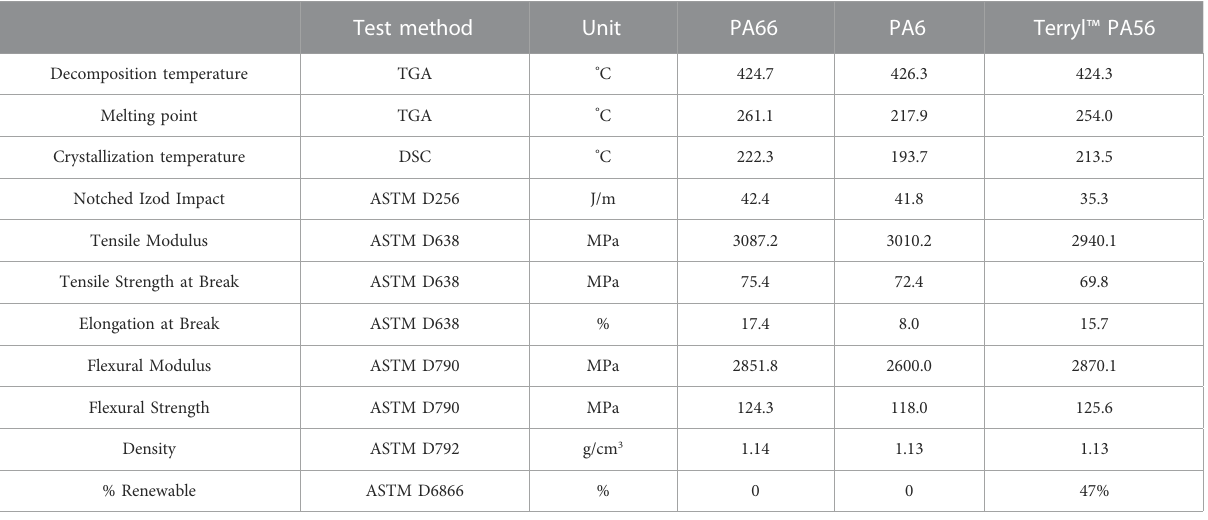
TABLE 2 Performance of PA6, PA66 and Terryl ™ PA56 (biotechnology innovation organization, 2005).